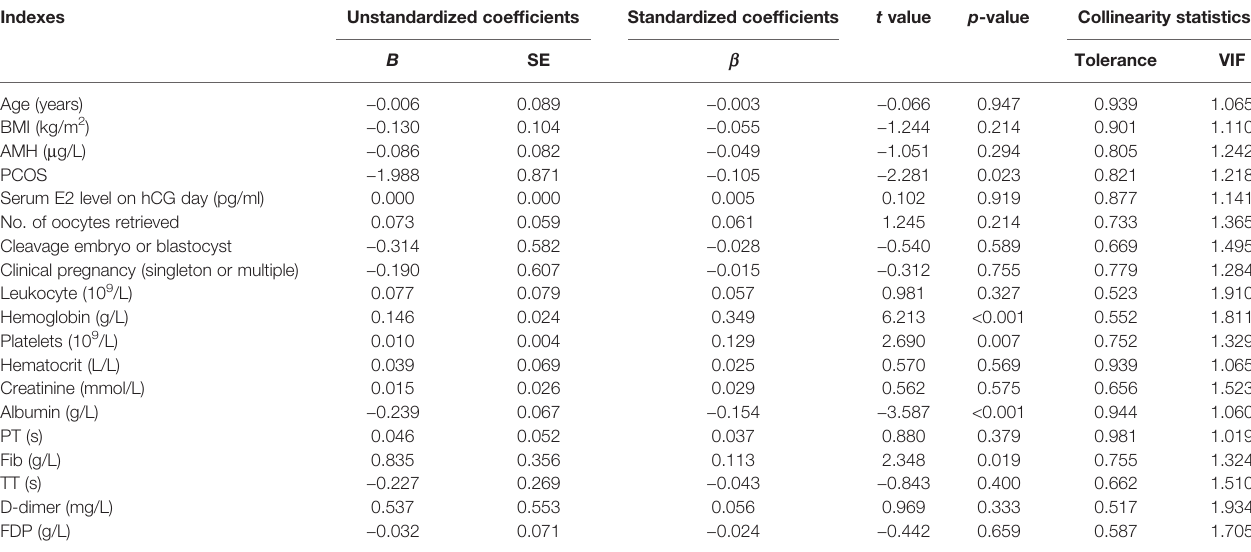
TABLE 4 | Multiple linear regression analysis of factors affecting recovery time.